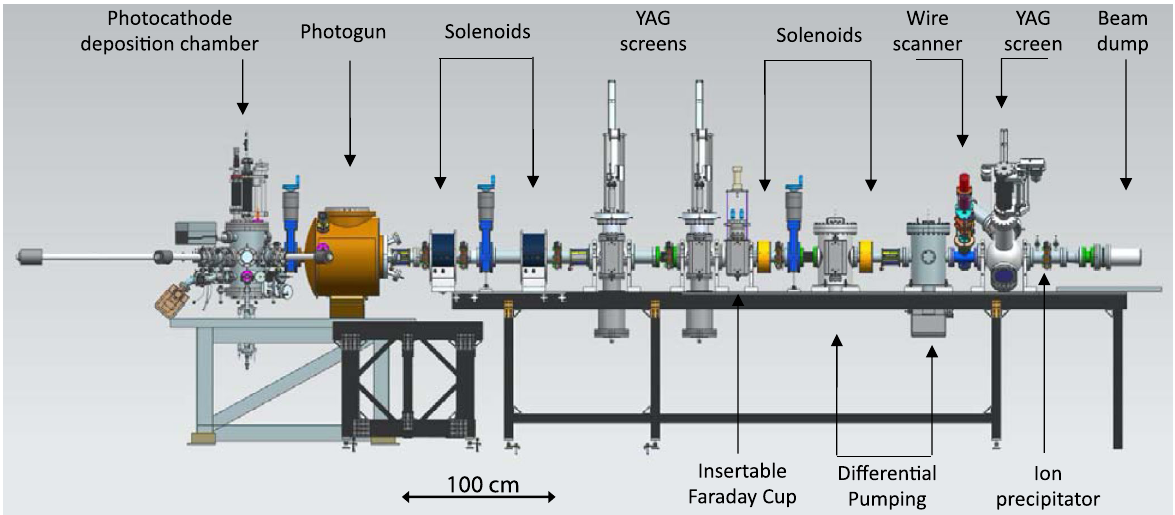
FIG. 5. Schematic of the photogun test stand and diagnostic beam